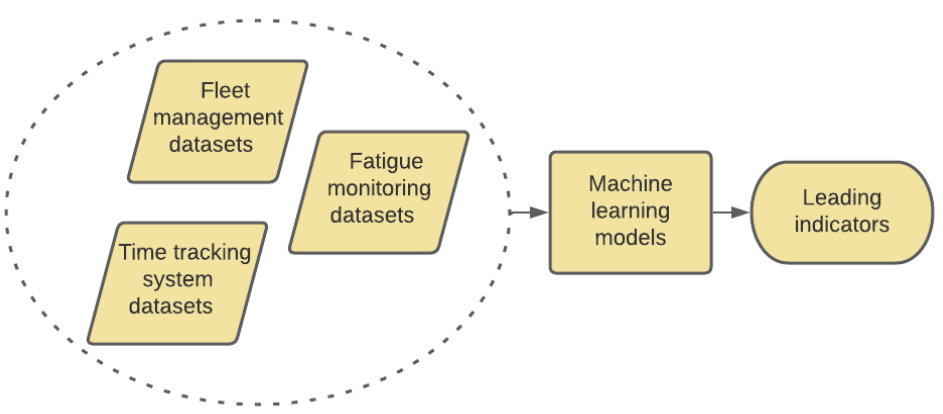
Figure 3. Process of